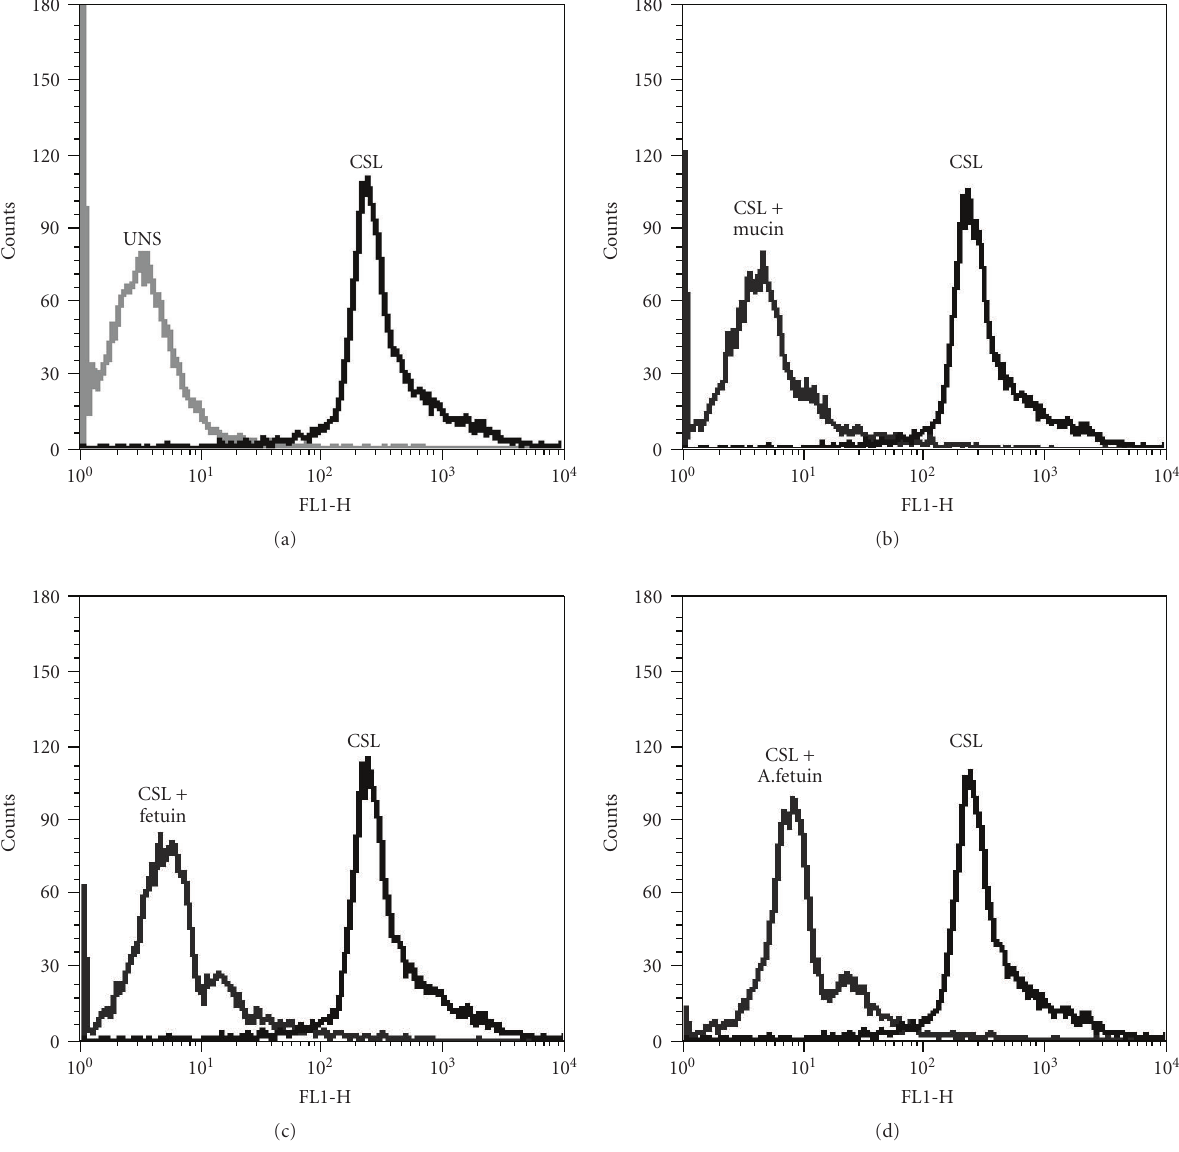
Figure 3: Binding of CSL to human PBMCs and inhibition of binding with competing glycoconjugates. PBMCs were stained with FITC- labeled CSL and subjected to flow cytometric analysis. X -axis, FL1-H on a log scale represents the fluorescence intensity of cells stained with FITC labeled CSL. Y -axis represents cell number. (a) The histoplot shows profiles of the unstained cells (UNS) and cells stained with FITC-labeled CSL (CSL). Profiles of cells stained with FITC-labeled CSL preincubated with di ff erent haptens are indicated in (b, c and